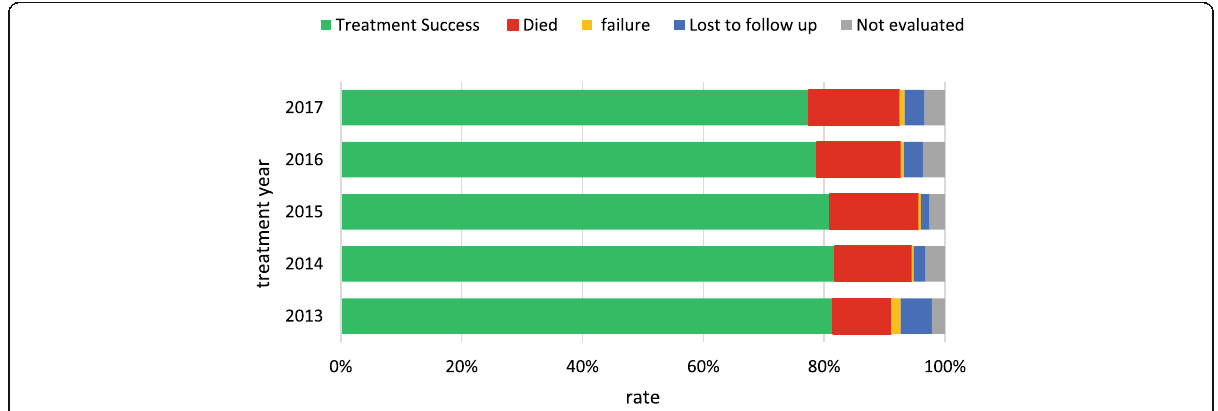
Fig. 5 Trends of TB treatment outcomes in 10 districts of the Volta region, Ghana,